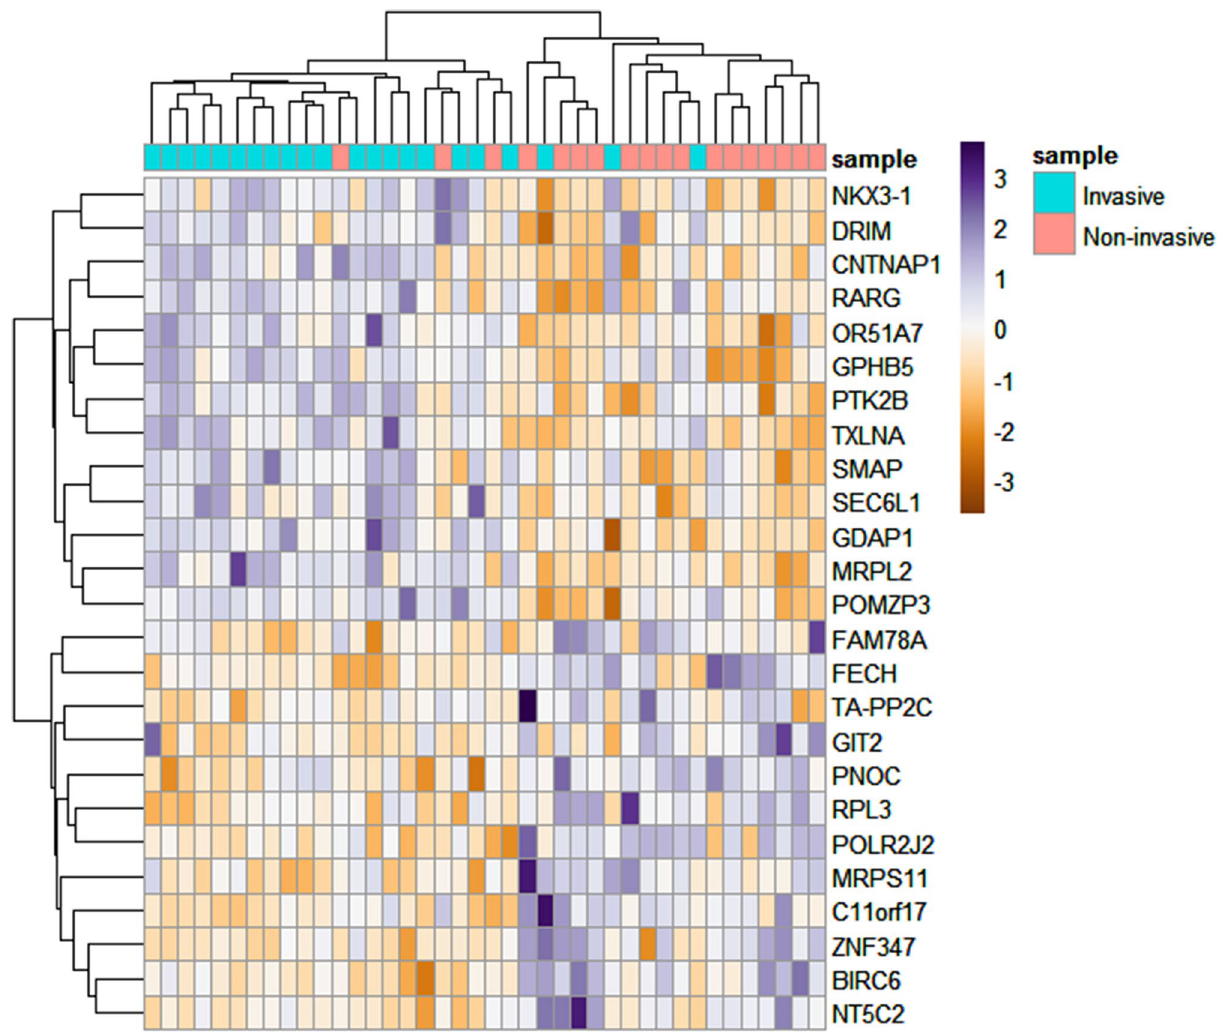
Figure 2. Random forest classification. This figure present 25 top importance genes selected based on Mean Decrease Accuracy